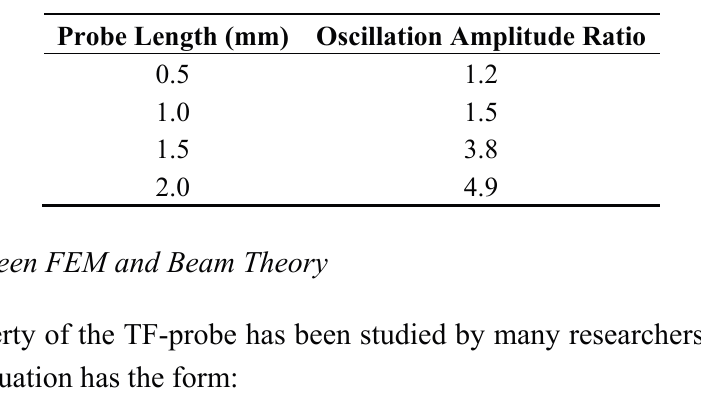
Table 11. Impact of the probe length on spatial resolution.